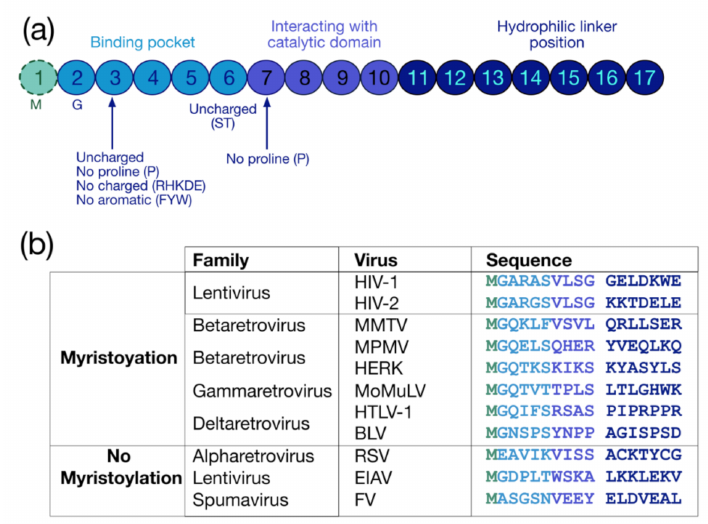
Figure 2. Protein sequence required for myristoylation and sequences of retroviral myristoylated MA domains. ( a ) Pro-myristoylated consensus sequence underlying the three regions regulating myristoylation: the binding pocket (positions 1–6), the catalytic domain (positions 7–10) and the hydrophilic linker (positions 11–17) [34,35]. ( b ) Comparison of the first 17 residues of myristoylated MA domains in different retroviruses. Myristoylation is generally conserved in retroviruses such as lentivirus (HIV-1), betaretrovirus (Mason-Pfizer monkey virus (MPMV), mouse mammary tumor virus (MMTV), and human endogenous retrovirus type K (HERK)), gammaretrovirus (Moloney murine leukemia virus (MoMuLV) and murine leukemia virus (MLV)), and deltaretrovirus (human T-lymphotropic viruses (HTLV-1) and bovine leukemia virus (BLV)), but not in alpharetrovirus (Rous sarcoma virus (RSV)), some other lentivirus (equine infectious anemia virus (EIAV)), and in spumavirus (foamy virus